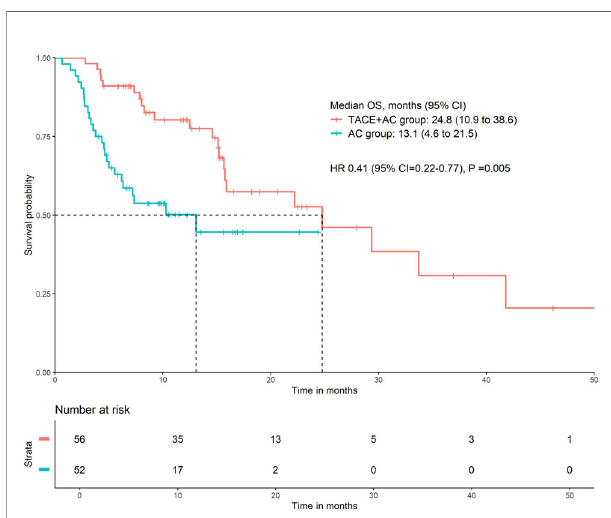
FIGURE 2 | Kaplan – Meier curve for OS. OS, overall survival; HR, hazard ratio; CI, con fi dence interval; TACE+AC, TACE plus apatinib plus camrelizumab; AC, apatinib plus camrelizumab; TACE, transcatheter arterial chemoembolization.